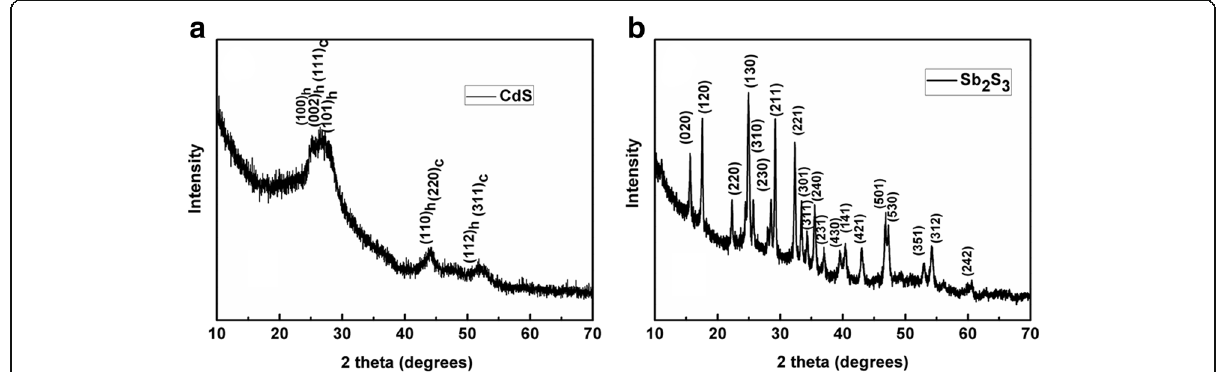
Fig. 2 XRD patterns of the thin films obtained by thermal decomposition of a (Cd(S 2 COEt) 2 (C 5 H 4 N) 2 ) and b Sb(S 2 COEt) 3 , respectively